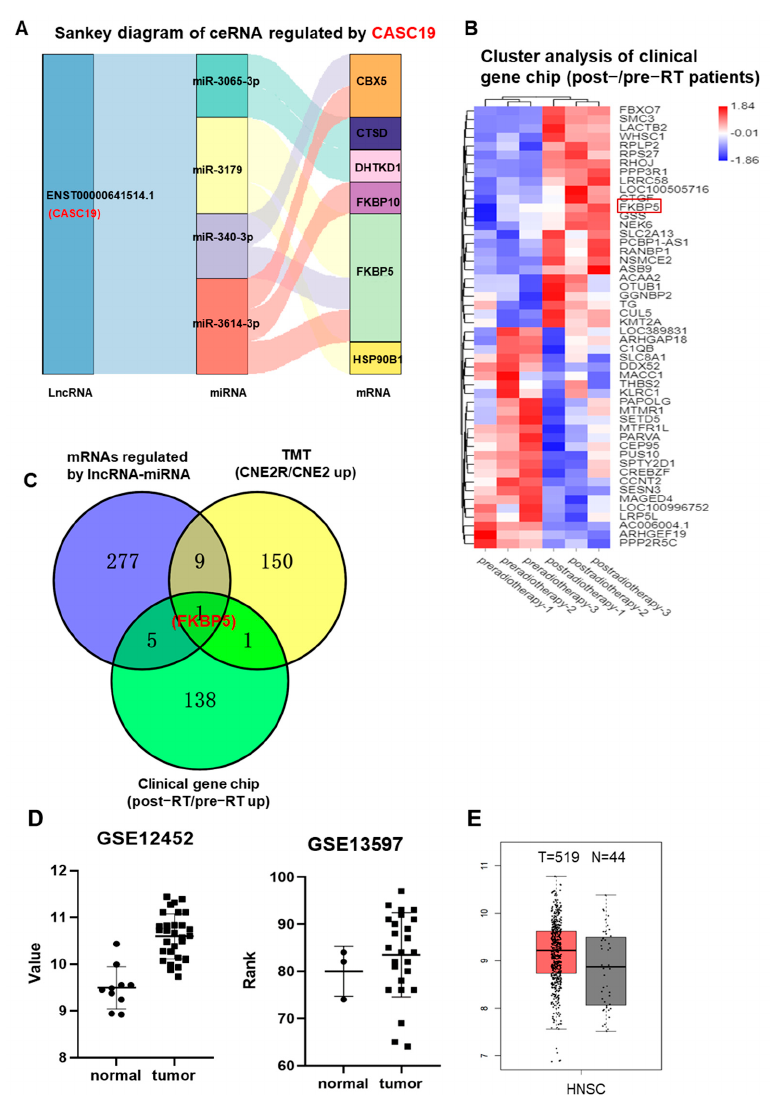
Figure 2. CASC19 − related ceRNA networks were constructed on the basis of mRNAs screen: ( A ) CASC19 − related ceRNA networks of 6 common upregulated genes (CBX5, CTSD, FKBP5, FKBP10, DHTKD1, and HSP90B1) based on the intersection of RNA − seq and TMT assays; ( B ) the heatmap of DEGs between tumor samples of NPC radioresistant patients before and after radiotherapy (n=3); ( C ) Venny chart of the intersection of the common genes among the upregulated mRNAs regulated by lncRNAs-miRNAs in CNE2R cells (RNA − seq assay), the upregulated genes in CNE2R cells compared with CNE2 cells (TMT assay), and the upregulated genes in the patients post-radiotherapy compared with pre-radiotherapy (clinic gene chip assay). The intersection only contains one gene FKBP5; ( D ) the expressions of FKBP5 in the tumor tissues of NPC and its adjacent normal tissues (data from GEO databases of GSE12452 and GSE13597); ( E ) the expressions of FKBP5 in the head and neck squamous cell carcinoma (HNSC) and its adjacent normal tissues (data from GEPIA).